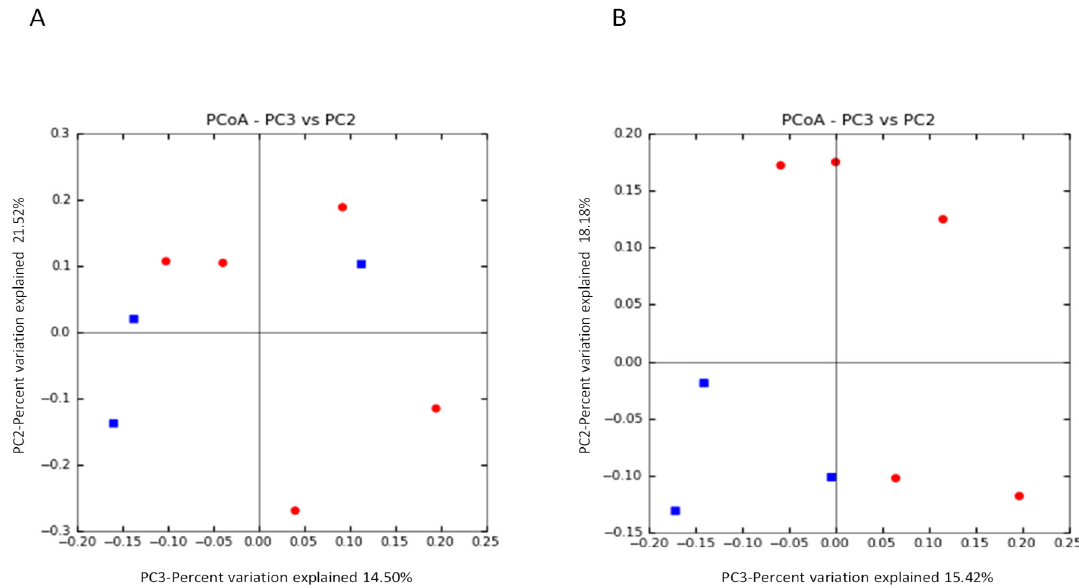
Figure 3. Weighted UniFrac principal coordinates analysis (PCoA) plots of fecal microbiota composition from the women in the study ( n = 8) before soy isoflavone intervention ( A ), and after one month of daily supplementation ( B ). Subject color coding: red, equol non-producers ( n = 5); blue, equol producers ( n = 3).